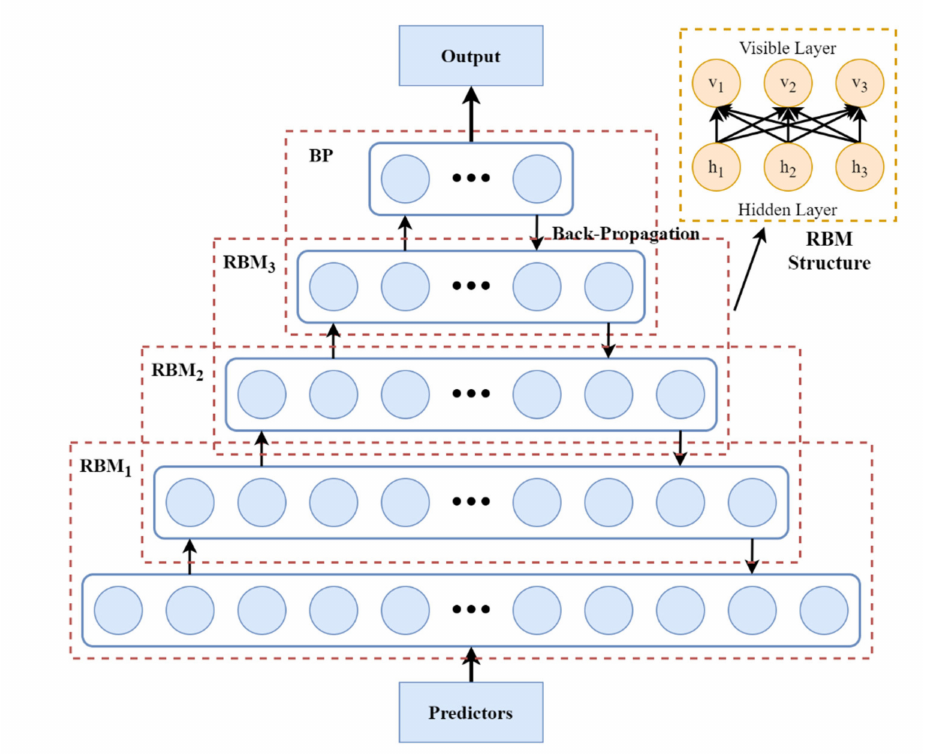
Figure 3. The structure of deep belief neural